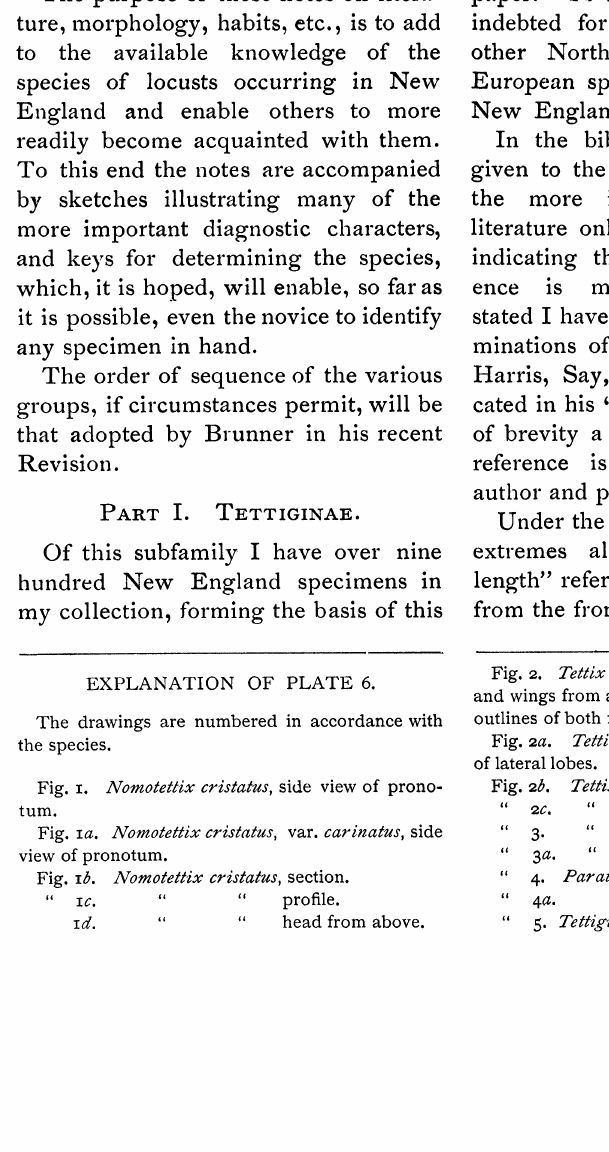
Fig. x. Nomotettix cristatus, side view of prono- turn. Fig. Ia. Nomotettix cristatus, var. carinatus, side view of pronotum. Fig. 13. Womotettix cristatus, section. ic. profile. Id. head from above.